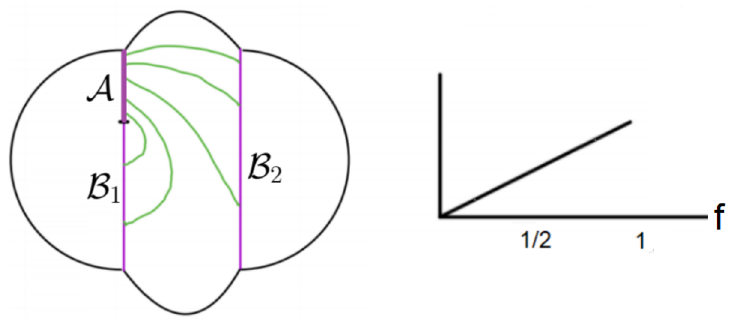
Figure 10 . The left horizon split into two components and the bit-thread diagram for entanglement between A and B .The right panel shows the entanglement entropy as a function of f